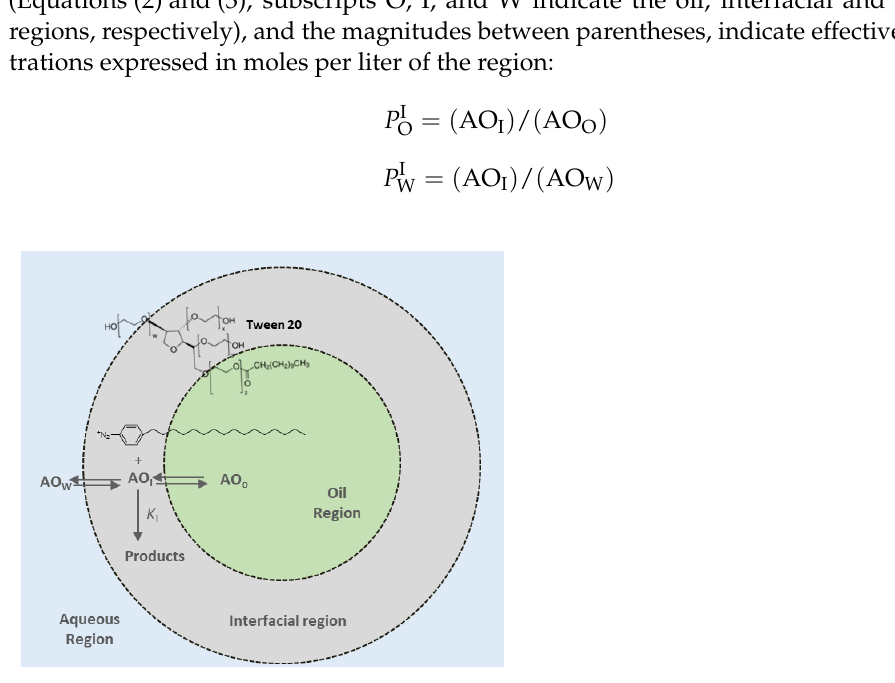
Figure 1. Partitioning of phenols between the different regions of a model emulsified system. k I is the rate constant for the reaction between 16-ArN 2+ and the AO in the interfacial region.